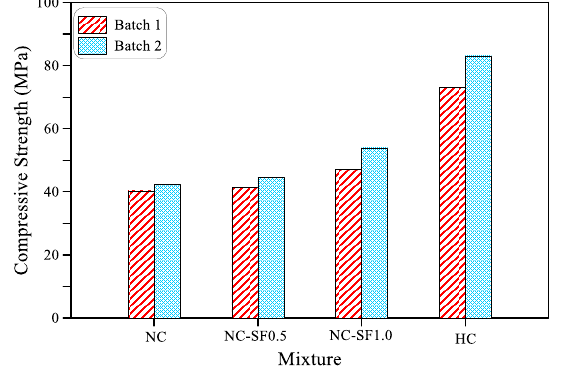
Figure 4. Compressive strength of all mixtures.